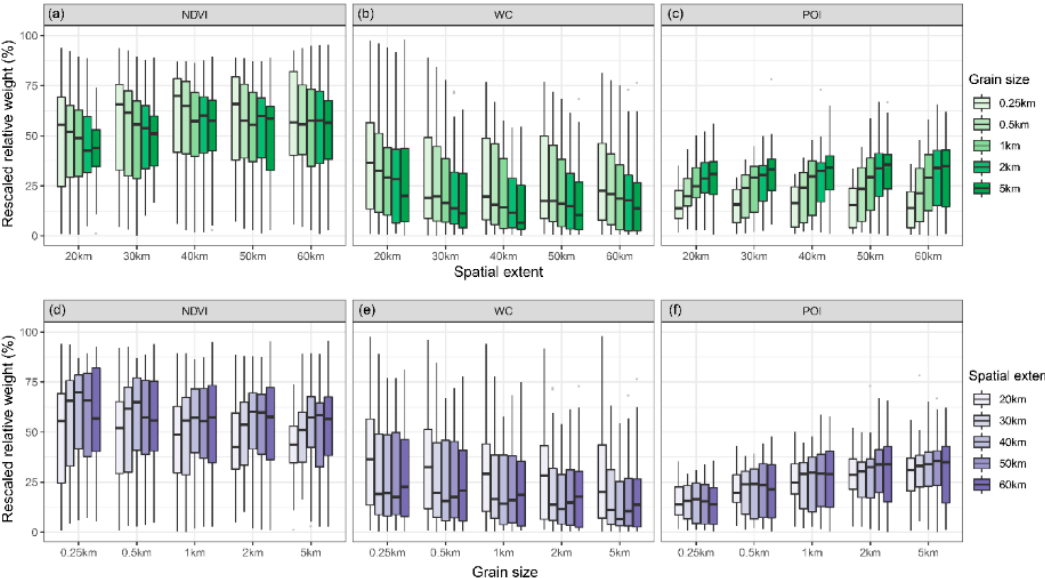
Figure 4. The boxplot of the relative importance of NDVI, water cover (WC), and POI density for explaining the LST patterns across the grain size range from 0.25 km to 5 km (at each fixed spatial extent, a – c ) and the spatial extent range from 20 to 60 km (at each fixed grain size, d – f ).